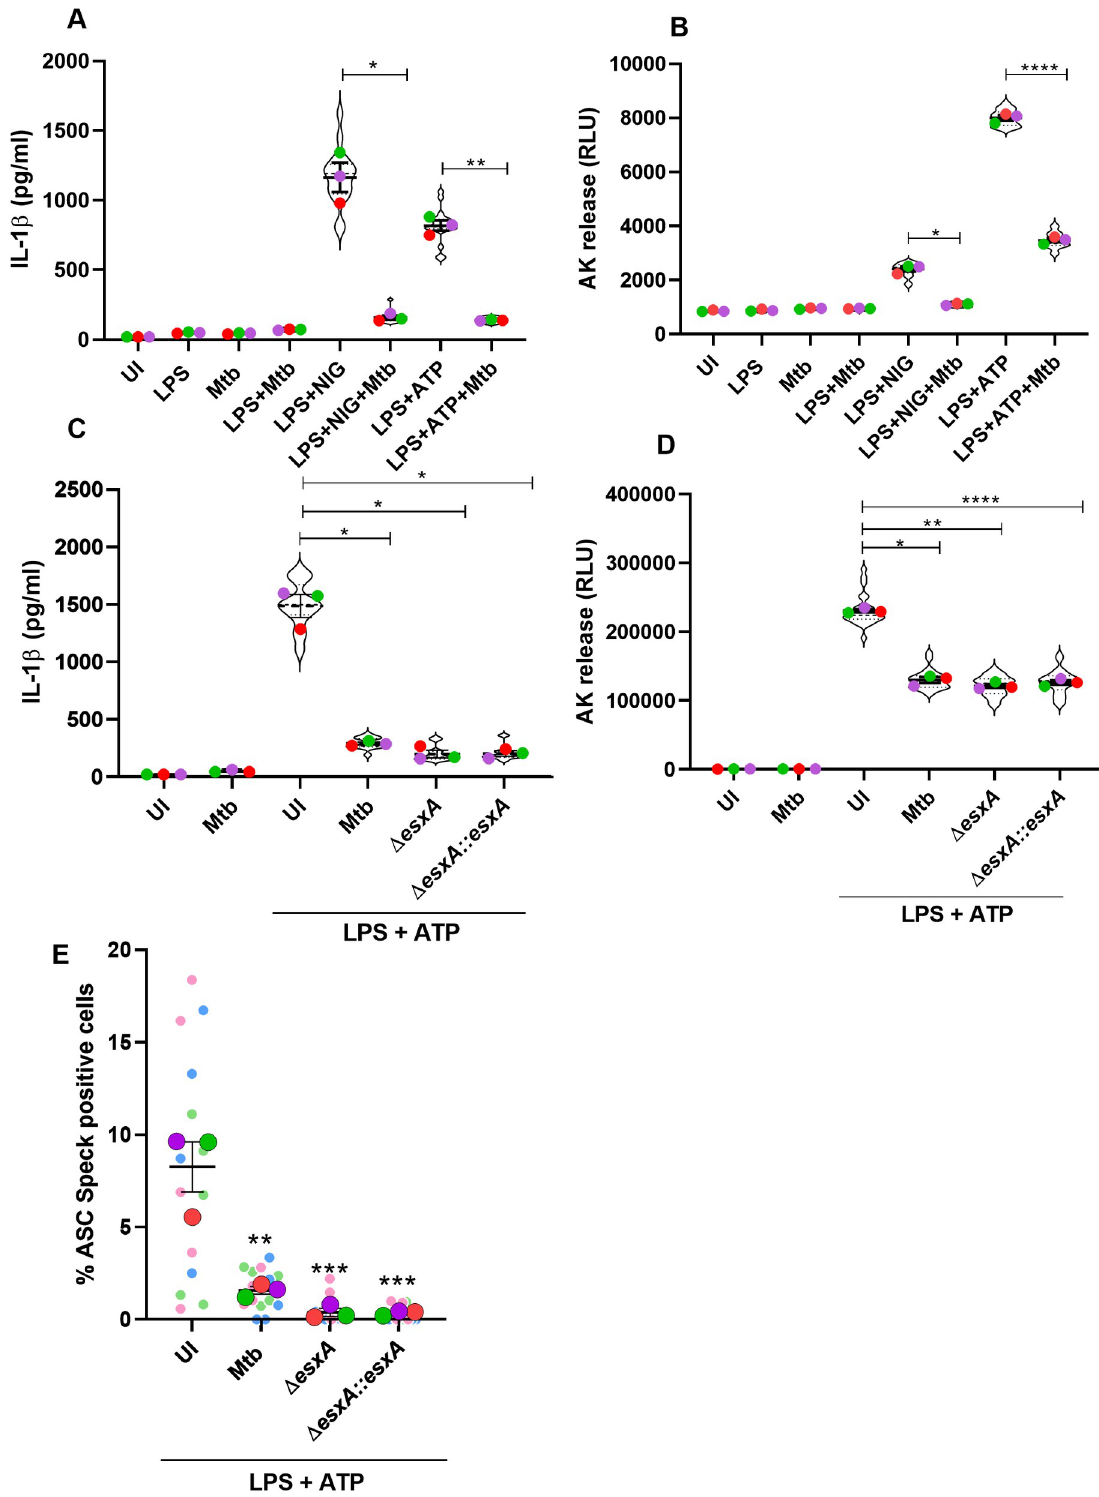
Fig 1. Mtb inhibits the NLRP3 Inflammasome activation in an ESX-1-independent mechanism. BMDMs were primed with 100ng/ml LPS for 4 h and concurrently infected with Mtb (CDC1551) at an MOI of 10 or left uninfected and then stimulated with two different NLRP3 inflammasome activators, Nigericin (NIG, 1 μ M) and ATP (0.1mM) for 30 min. Uninfected and untreated cells (UI), only LPS-